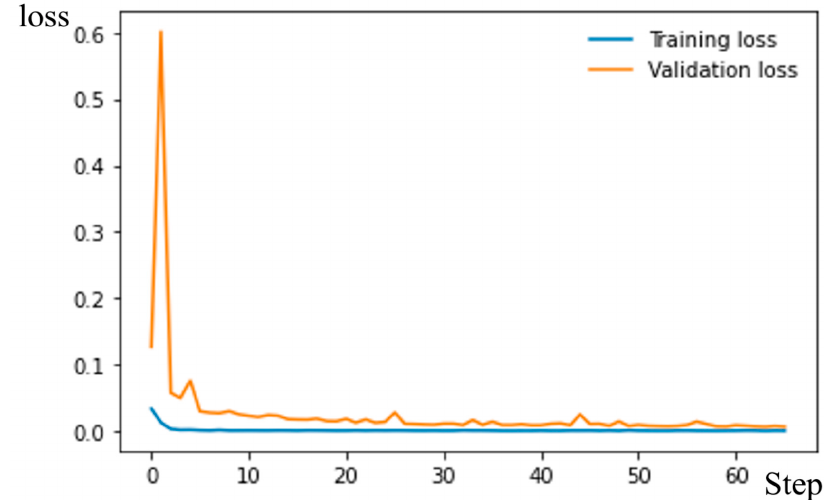
Figure 5. The Logistic Loss curve for the binary classification model “legs–no legs”. As can be seen in Figure 5, the model was not overtrained since the validation log loss curve decreased up to 25 step and then tended asymptotically to a constant